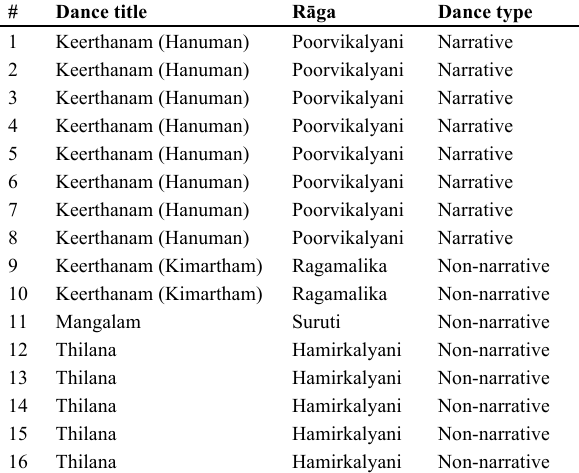
Table 1. Dance title, r ā ga , and dance type associated with each video (#). The t āḷ a for all videos was Adi . The music was composed by Alakananda